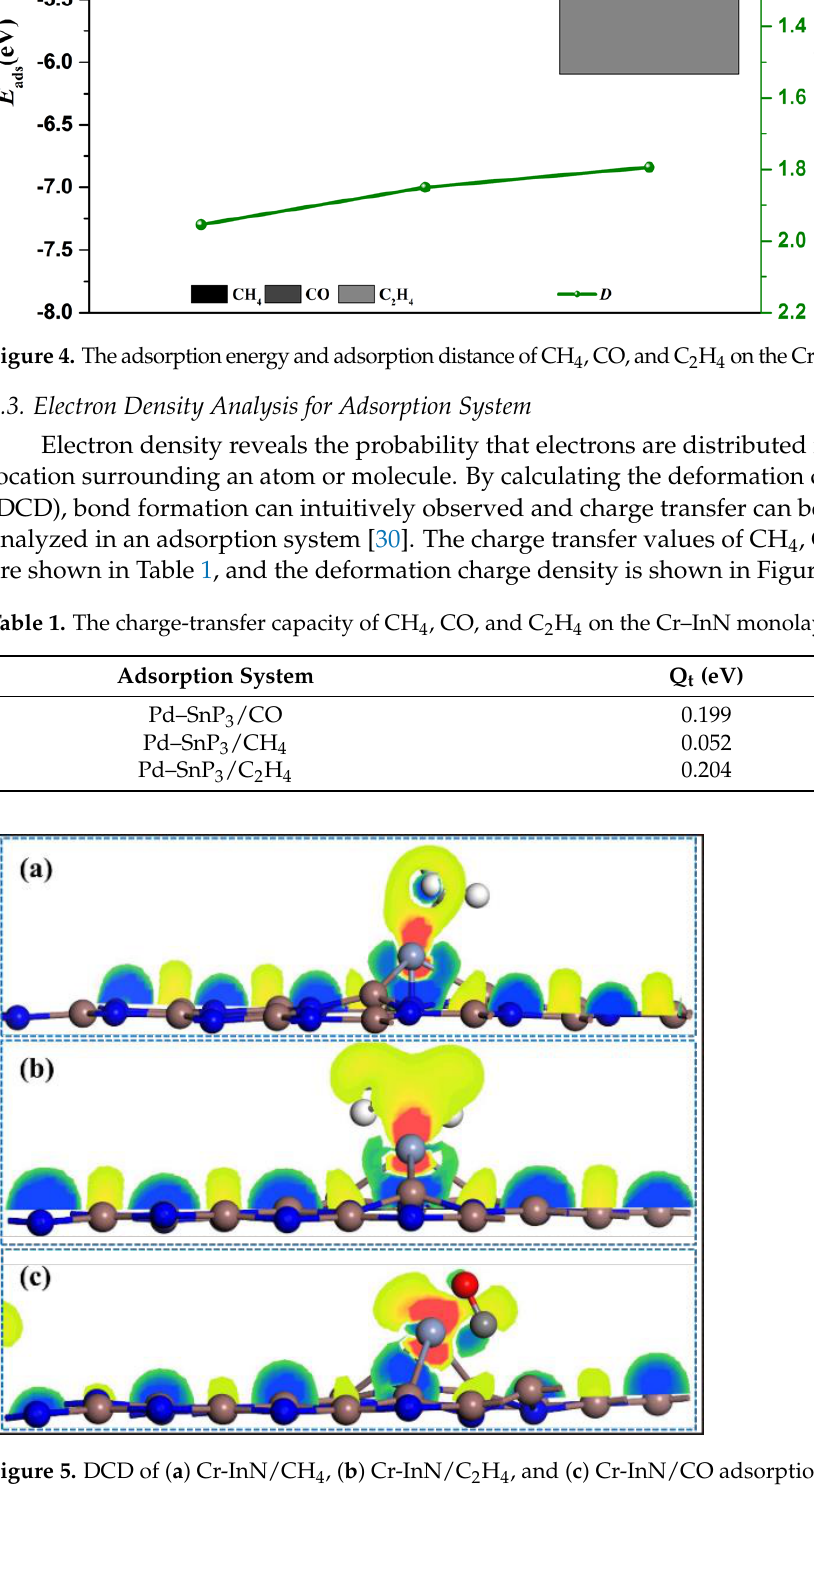
Figure 3. Geometric construction of ( a ) Cr-InN/CH 4 , ( b ) Cr-InN/CO, and ( c ) Cr-InN/C 2 H 4 adsorption systems.